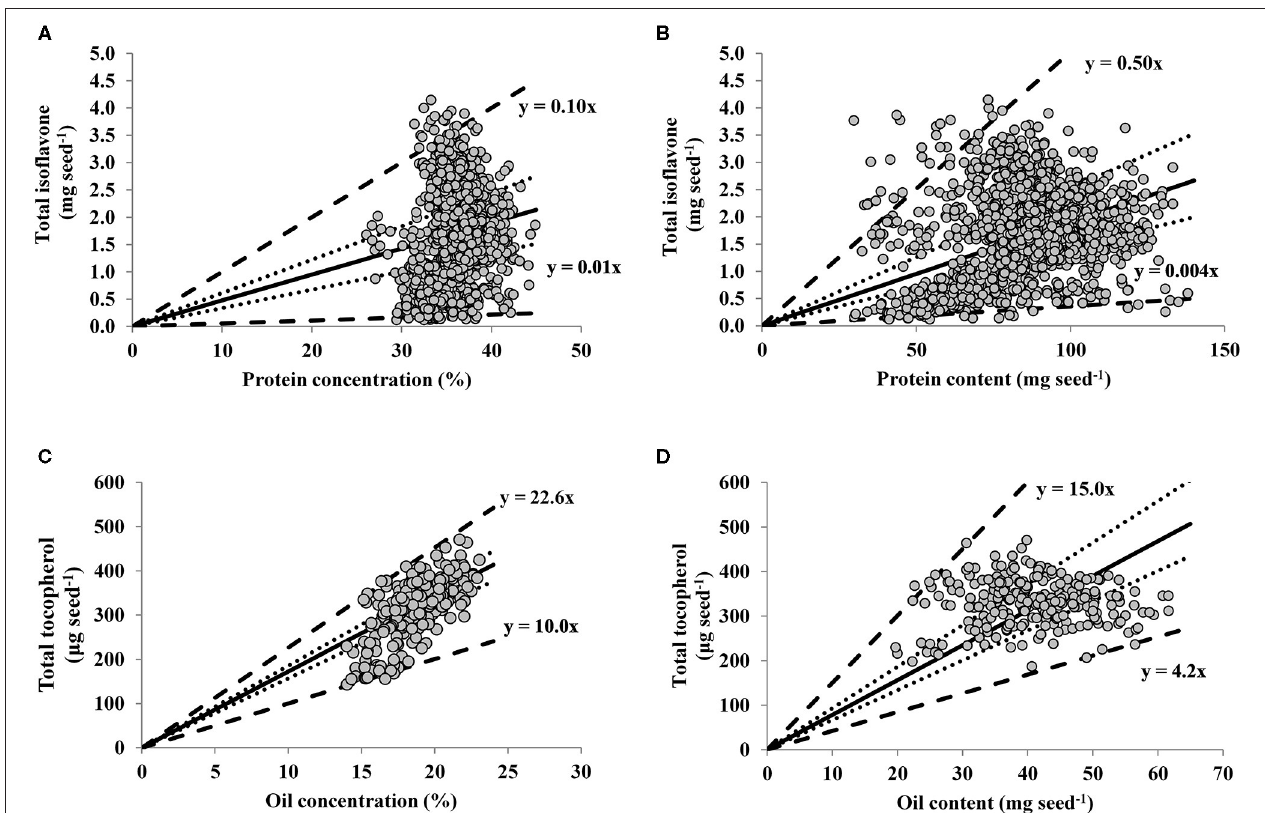
FIGURE 2 | Relationships between seed total isoflavone (mg seed − 1 ) vs. protein concentration (%, adjusted to 13% moisture content) (A) and vs. protein content (mg seed − 1 ) (B) ; and between soybean seed total tocopherol ( µ g seed − 1 ) vs. oil concentration (%, adjusted to 13% moisture content) (C) and vs. oil content (mg seed − 1 ) (D) across a range of soybean genotypes and environments. In all panels lines represent quantile regression for percentiles 1 and 99 (thick dotted lines) percentiles 25 and 75 (dotted lines). The solid line is the average fit of the data, for which the following models were computed: (A) Y = − 0.37 + 0.06 X , adjusted R 2 = 0.03, P < 0.0001; (B) Y = 0.81 + 0.01 X , adjusted R 2 = 0.06, P < 0.0001; (C) Y = − 118.93 + 23.27 X , adjusted R 2 = 0.48, P < 0.0001; (D) Y = 326.0 + 0.15 X , adjusted R 2 = 0.00, P =